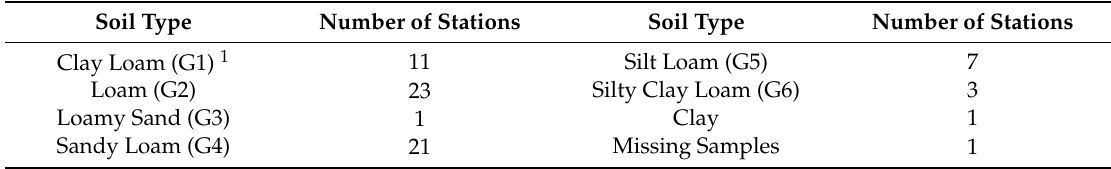
Table 3. Distribution of soil types for stations.